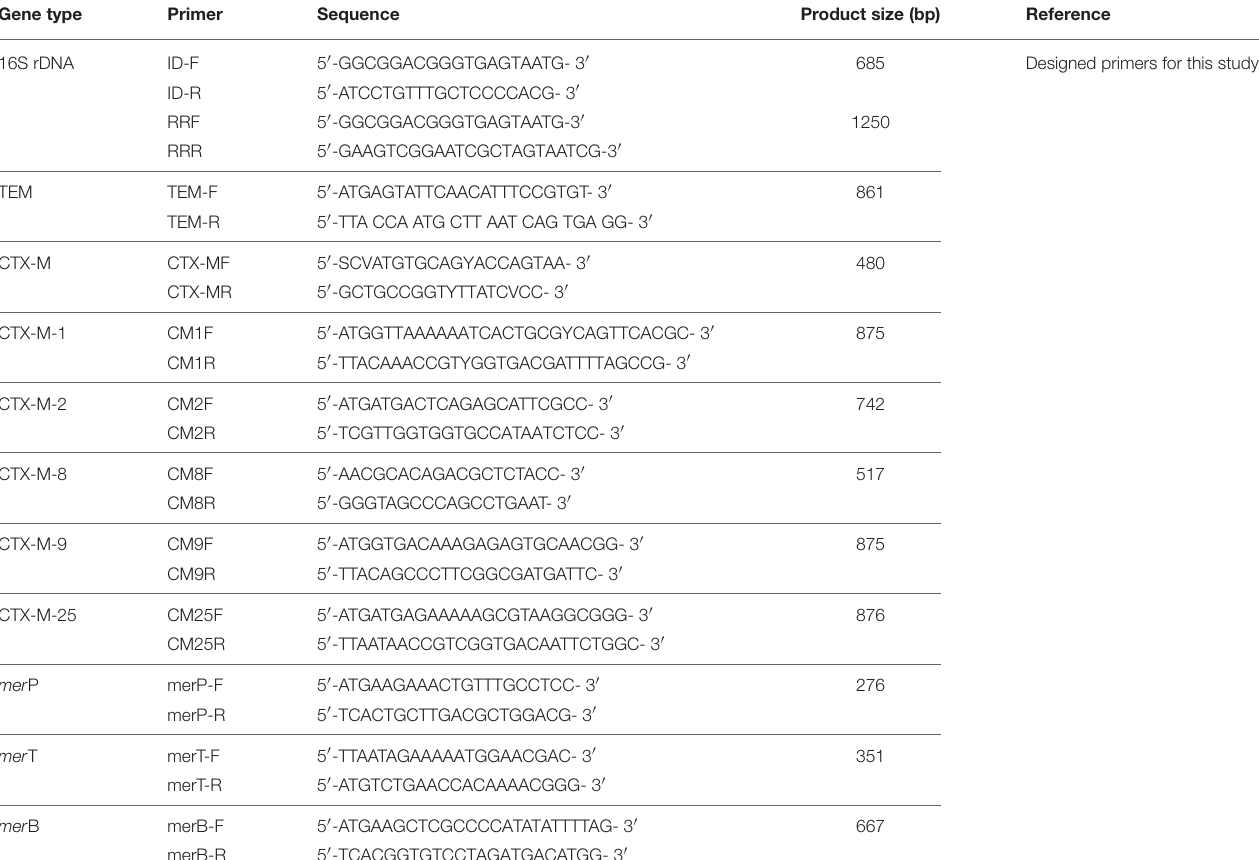
TABLE 1 | Sequences of primers used for the detection of different genes among ESBL + isolates. Gene